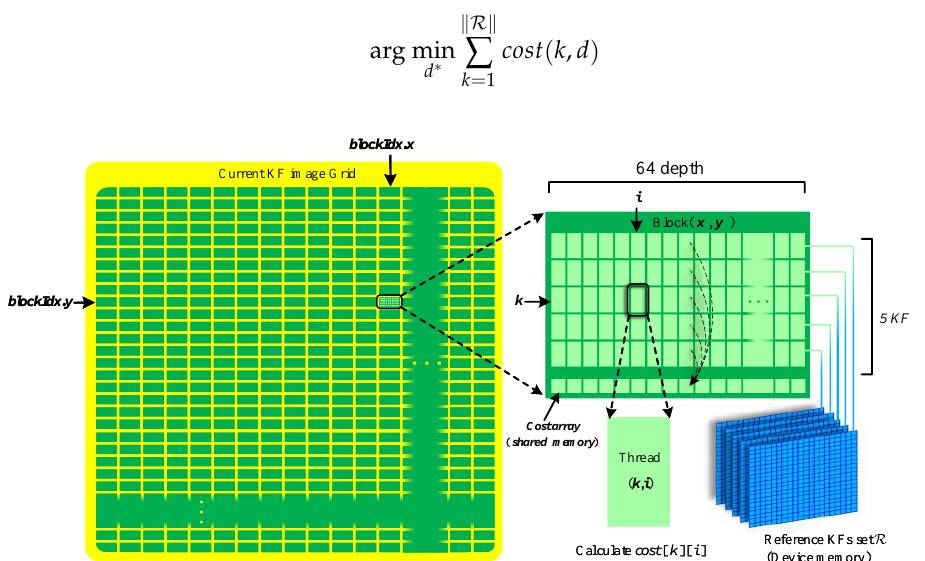
Figure 6. The composition of computing structure in GPU. The yellow box on the left represents block arrays, and the green box on the right represents thread arrays. Device memory can be accessed by all blocks and threads, while shared memory can be accessed by threads in the same